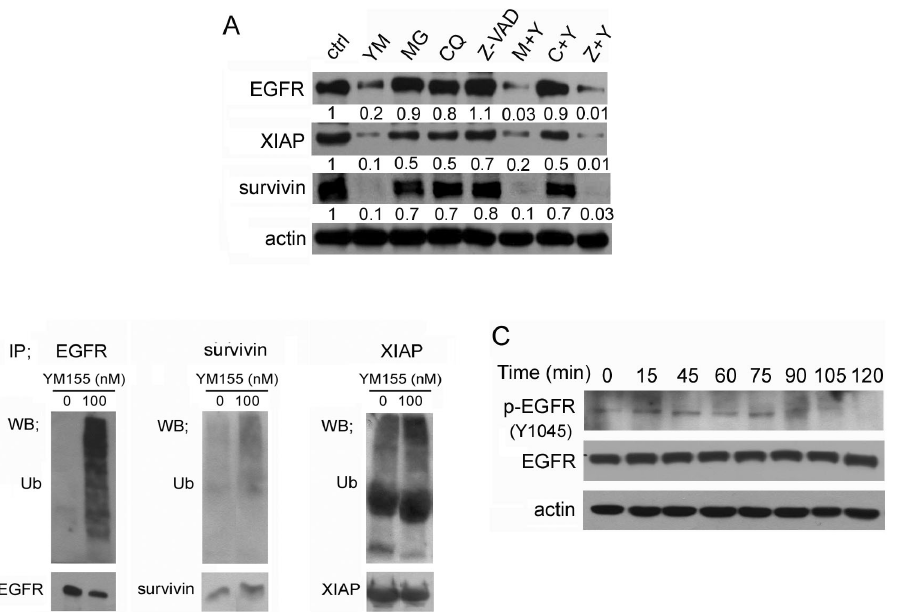
Figure 5. YM155 induces EGFR phosphorylation, EGFR ubiquitination and degradation of EGFR via the lysosome in PANC-1 cells. A, YM155 induced lysosomal degradation of EGFR, XIAP, and survivin in PANC-1 cells. PANC-1 cells were treated with 100 nM YM155 (YM), 10 m M MG- 132 (MG), 50 m M chloroquine (CQ), or 30 m M Z-VAD-fmk (Z-VAD) without or with YM155 for 24 hours. The expression ratios of EGFR, XIAP, or survivin to actin compared with the control are shown for each lane. ctrl, control; M + Y, MG-132 + YM155; C + Y, chloroquine + YM155; Z + Y, Z-VAD-fmk + YM155. B, PANC-1 cells treated with 100 nM YM155 for 6 hours were immunoprecipitated (IP) with antibodies against EGFR, survivin or XIAP, and analyzed by Western blotting for ubiquitin. C, The time-course of EGFR phosphorylation at Y1045 in PANC-1 cells after treatment with YM155 (100 nM) is